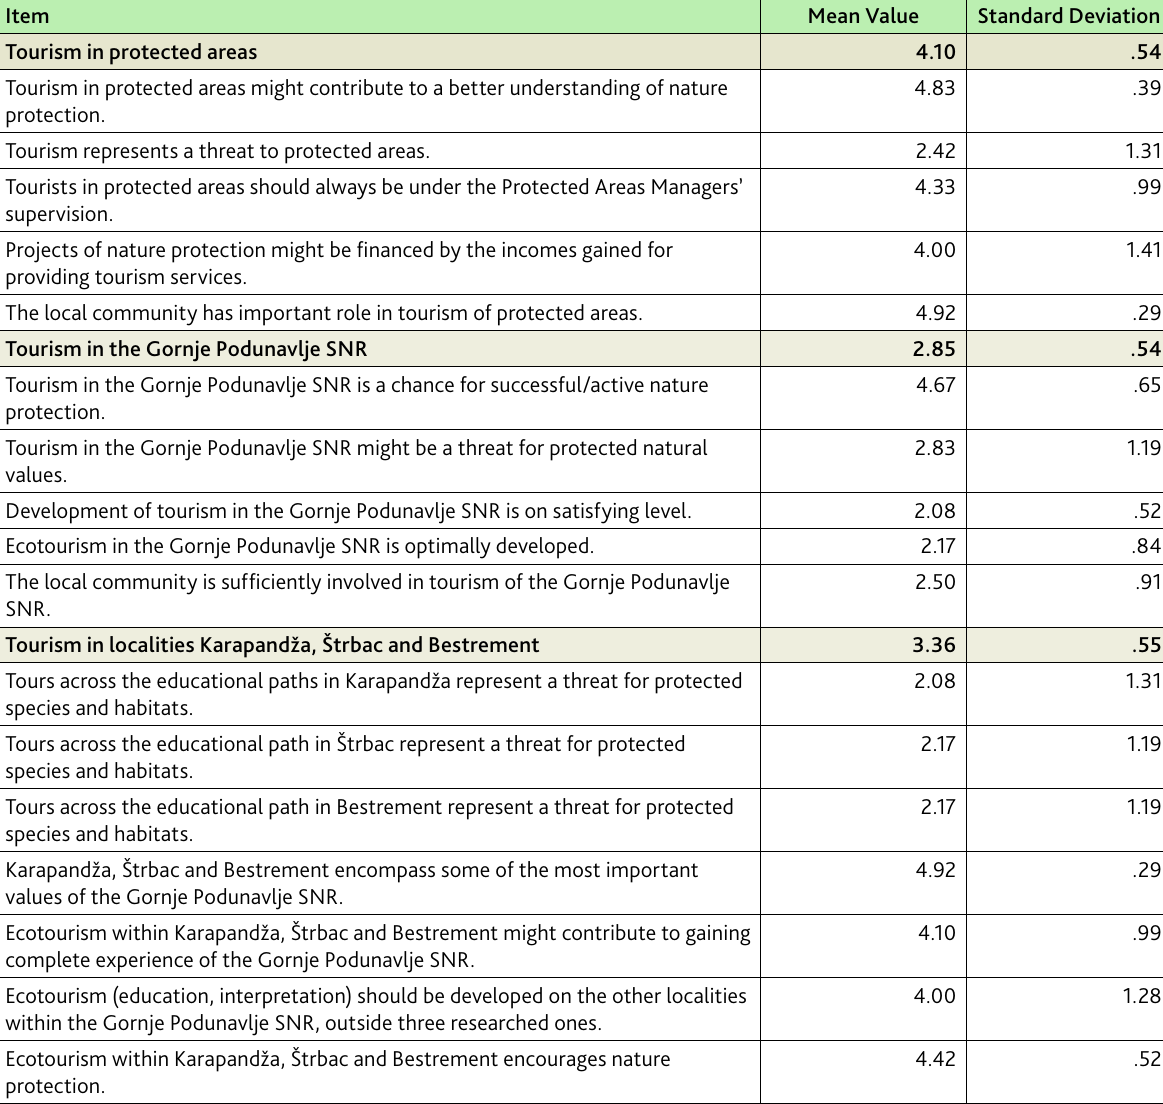
Table 4. Summarized respondents’